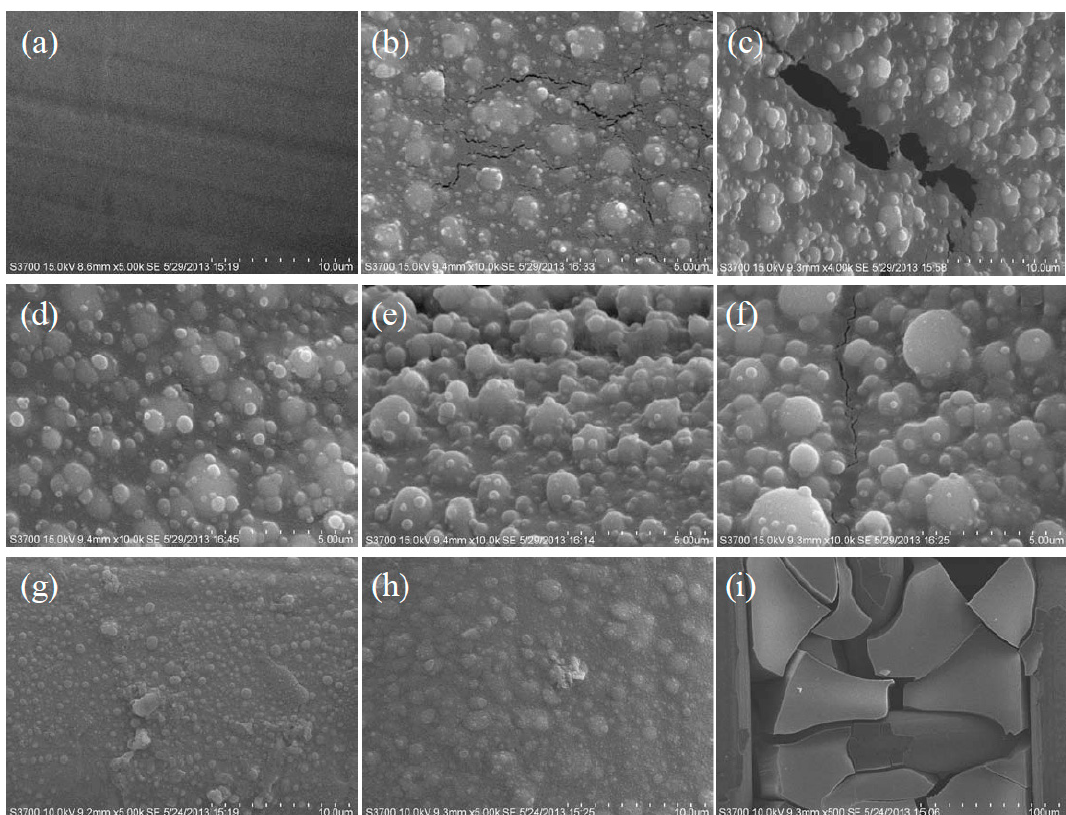
Figure 4. SEM images of hybrid-coated mesh films prepared from a stainless steel mesh with an average pore diameter of about 50 mm. The content of SiO 2 is ( a ) 33%, ( b ) 40%, ( c ) 50%, ( d ) 60%, ( e ) 66%, ( f ) 75%, ( g ) 80%, ( h ) 90% and ( i ) 100%. ( f ) 75%, ( g ) 80%, ( h ) 90% and ( i )